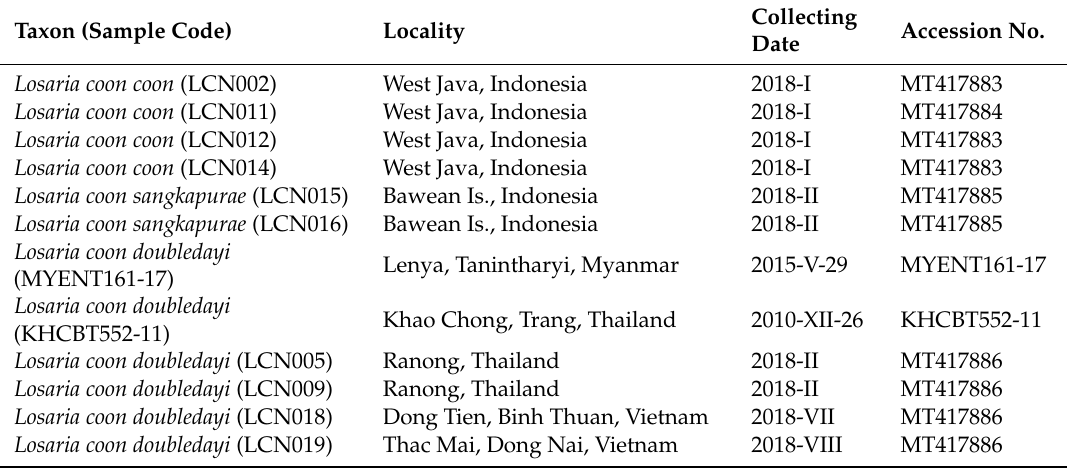
Table 1. Sampling information and GenBank / BOLD accession numbers of the Losaria species and outgroups used in this study. The taxon names follow current taxonomy, mentioned